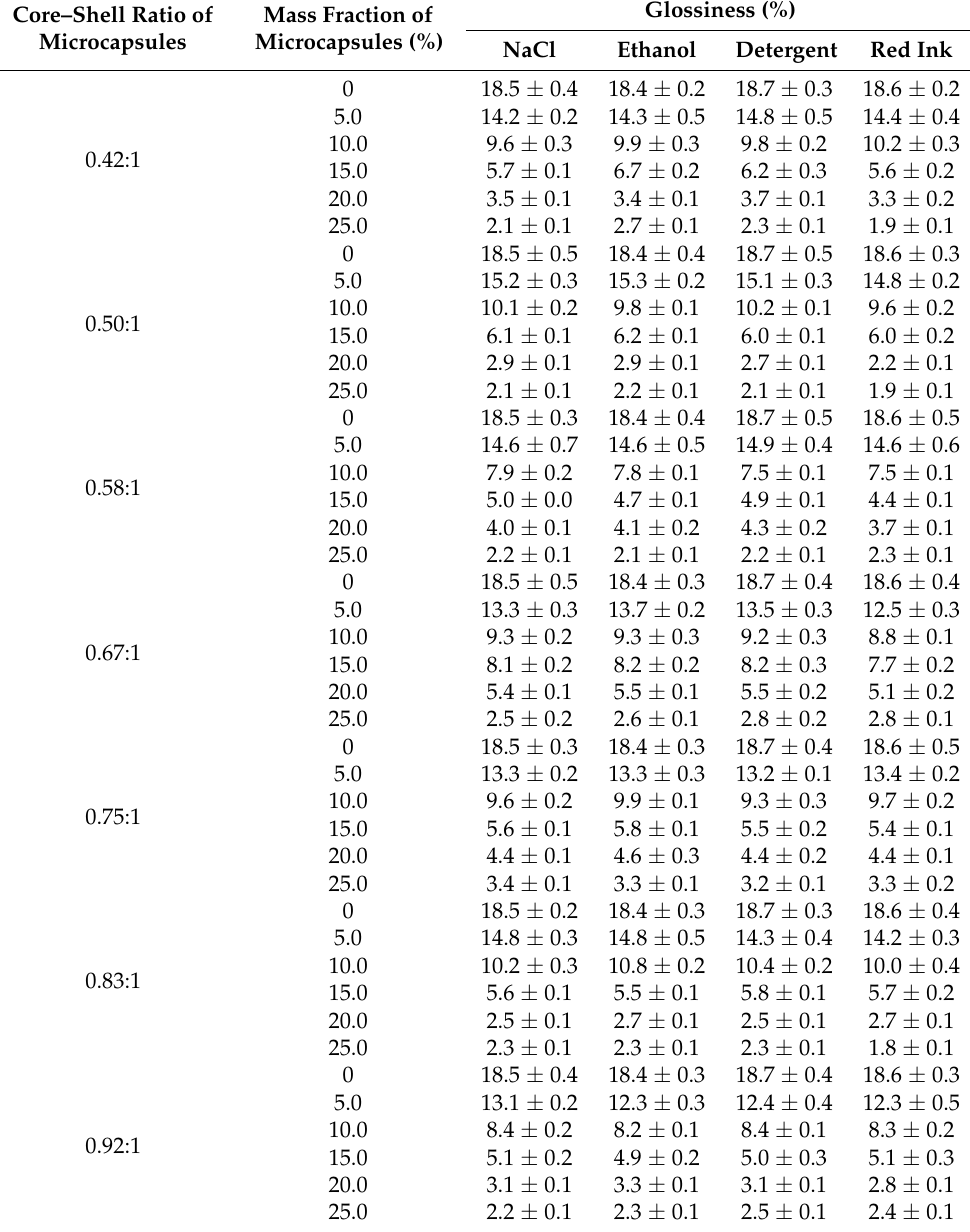
Table 8. Glossiness of the waterborne primer coatings after the resistance to liquid